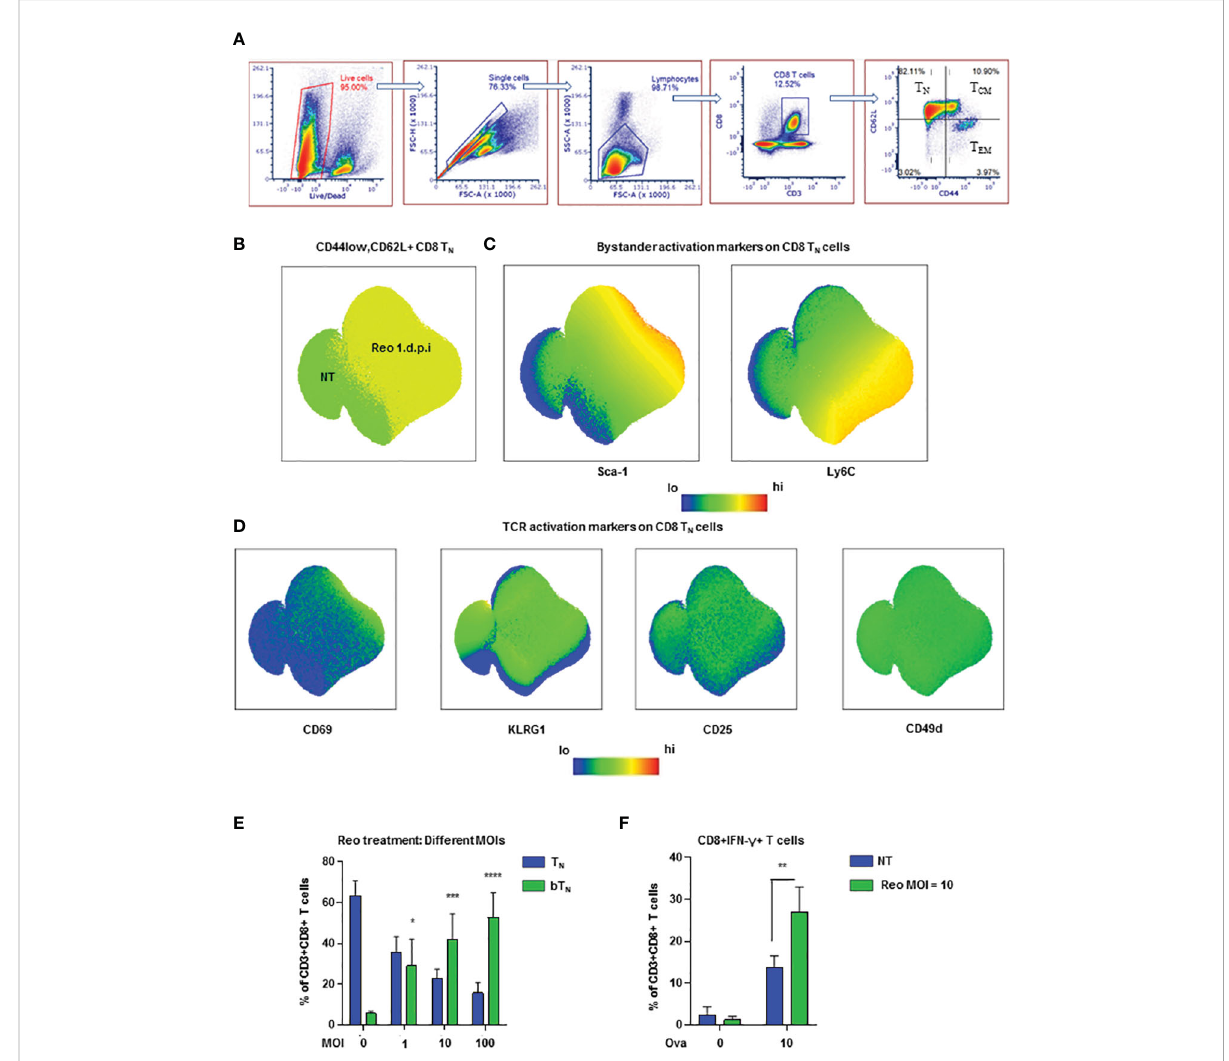
FIGURE 1 Reovirus induces early bystander activated naïve CD8 T cells in vivo (A) Representative dot plots demonstrating the gating strategy for the identi fi cation of CD8 T cell subsets- T N, T CM , T EM and CD44lowCD62Llow (n=3 mice per non-treated group). (B) UMAP showing CD8 T N cells in non-treated (NT) and reovirus treated (Reo 1 d.p.i.) C57BL/6 splenocytes. (C) UMAP depicting bystander activation markers in CD8 T N cells. (D) UMAP representing TCR activation markers in CD8 T N cells. (n=9 mice; NT-3 mice, Reo 1 d.p.i.-6 mice in all UMAP plots). (E) Bar graphs for the induction of CD8 bT N cells upon treatment of splenocytes from C57BL/6 mice with varying MOIs of reovirus (n=3 independent experiments). (F) Bar graphs for % of CD8+IFN- g + T cells in OT-1 splenocytes (n=3 independent experiments). Two-way ANOVA with 95% con fi dence interval was used for statistical analysis in bar graphs. Signi fi cance has been indicated only for CD8 bT N cell populations induced within 24 hours in comparison with untreated control population levels. Not signi fi cant (ns) = p > 0.05; * p < 0.05; ** p < 0.01; *** p < 0.001; **** p <